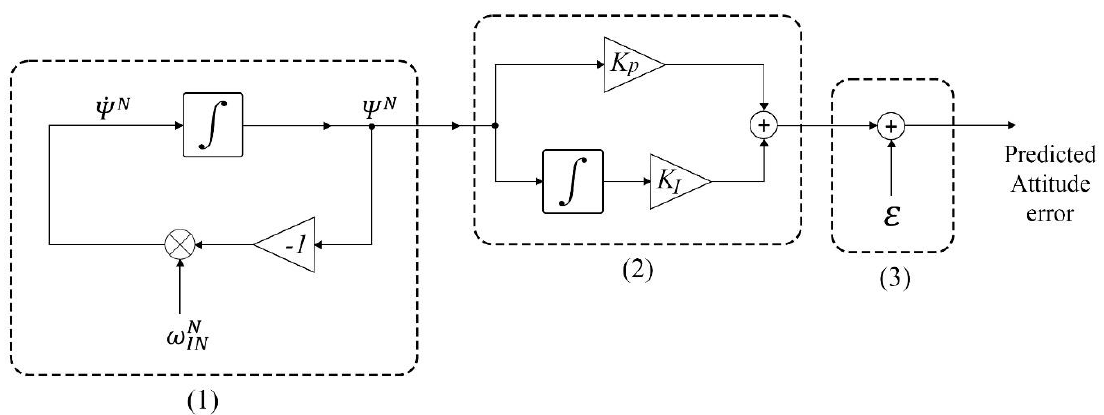
Figure 2. Block diagram of attitude error prediction, PI controller, and regulator. ( 1 ) Attitude error prediction; ( 2 ) PI controller; ( 3 ) regulator.